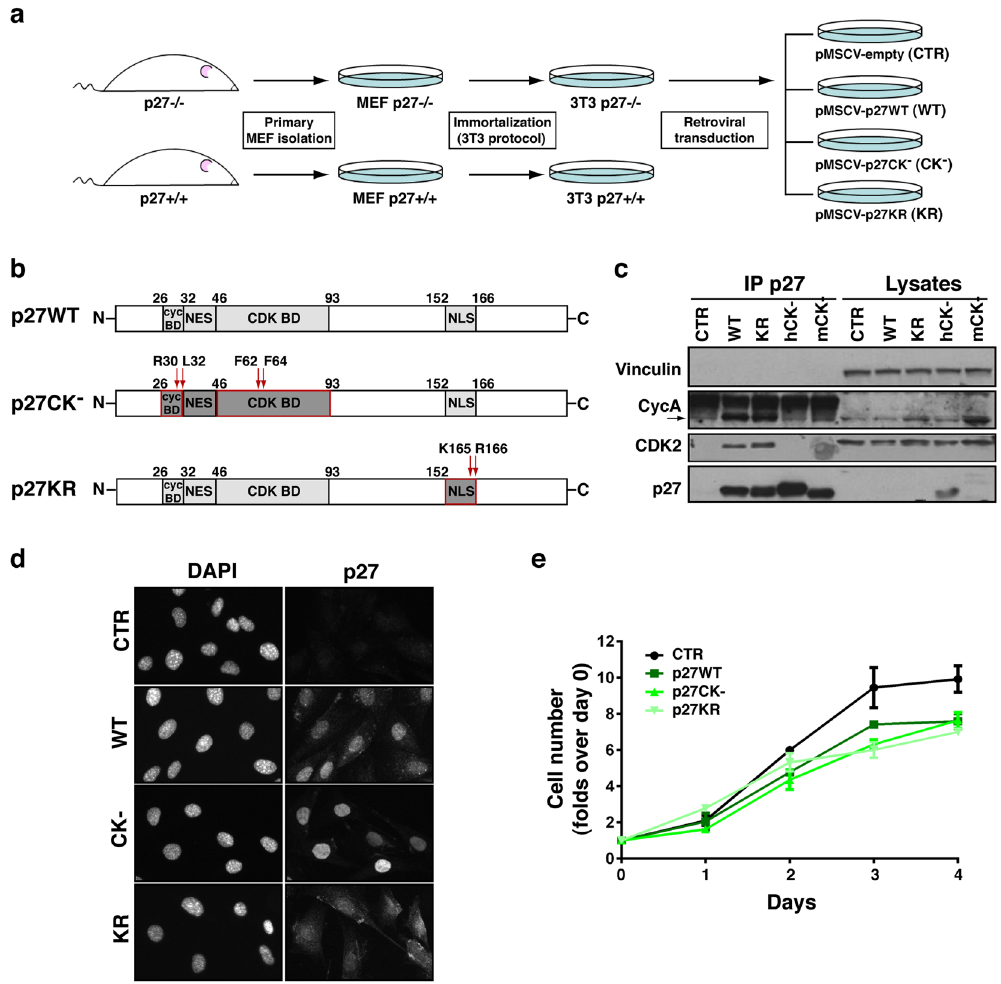
Figure 1. Generation of p27KO and mutant p27 3T3 mouse fibroblasts. ( a ) Schematic representation of the experimental workflow used to generate 3T3 p27 mutant clones. Briefly, fibroblasts were harvested from p27KO mouse embryos, immortalized using the 3T3 protocol and transduced with p27 WT or mutants of interest. ( b ) Schematic representation of p27 WT protein structure and the two mutants of interest, generated by point mutations in the cyclin- CDK- binding domains (p27 CK − ) or in the nuclear localization signal (p27 KR ). ( c ) Western Blot analysis of immunoprecipitated (IP) proteins and lysates harvested from indicated 3T3 cell clones. CTR represents p27KO fibroblasts; WT, KR, CK − represent respectively the p27WT, KR and CK − represents (both human and mouse) transduced-fibroblasts. ( d ) Immunofluorescence analysis of above described clones, showing p27 expression and localization. Nuclei were stained with DAPI. ( e ) Growth curve analysis of above described clones. Cells were plated in 6-well plates in duplicates and counted every day, for 4 consecutive days. Data are expressed as fold increase over the number of plated cells (1 × 10 5 ) with standard deviation. MEF, mouse embryo fibroblasts; BD, binding domain; NLS, nuclear localization signal; NES, nuclear export